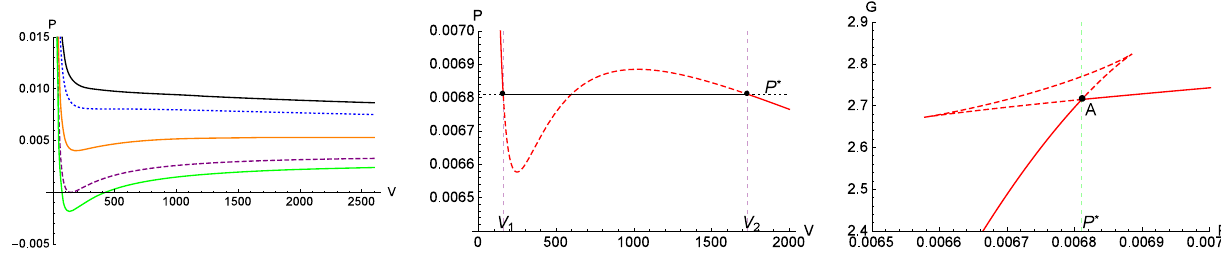
isobar P ∗ = 0 . 00681, V 1 and V 2 correspond to r 1 = 2 . 38204 and r 2 = 4 . 32768, respectively. Corresponding to the middle diagram, the Gibbs free energy described by Eq. (3.15) is depicted in the right dia- gram , showing the characteristic swallowtail behavior